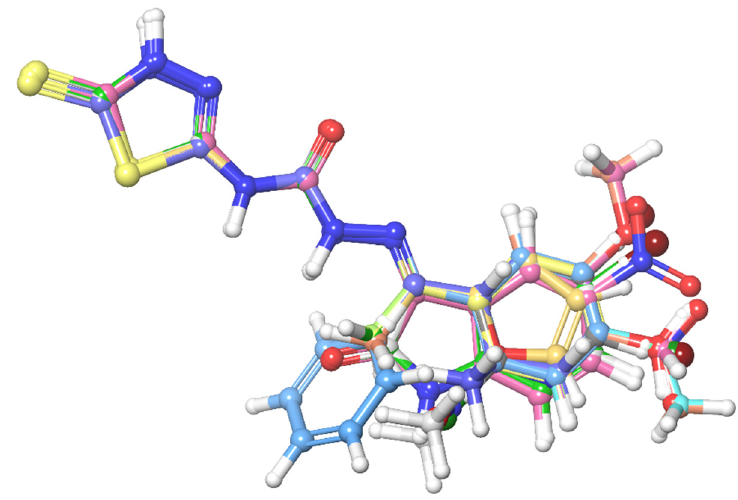
Figure 2. Molecular alignment of all the compounds taken in the QSAR study.